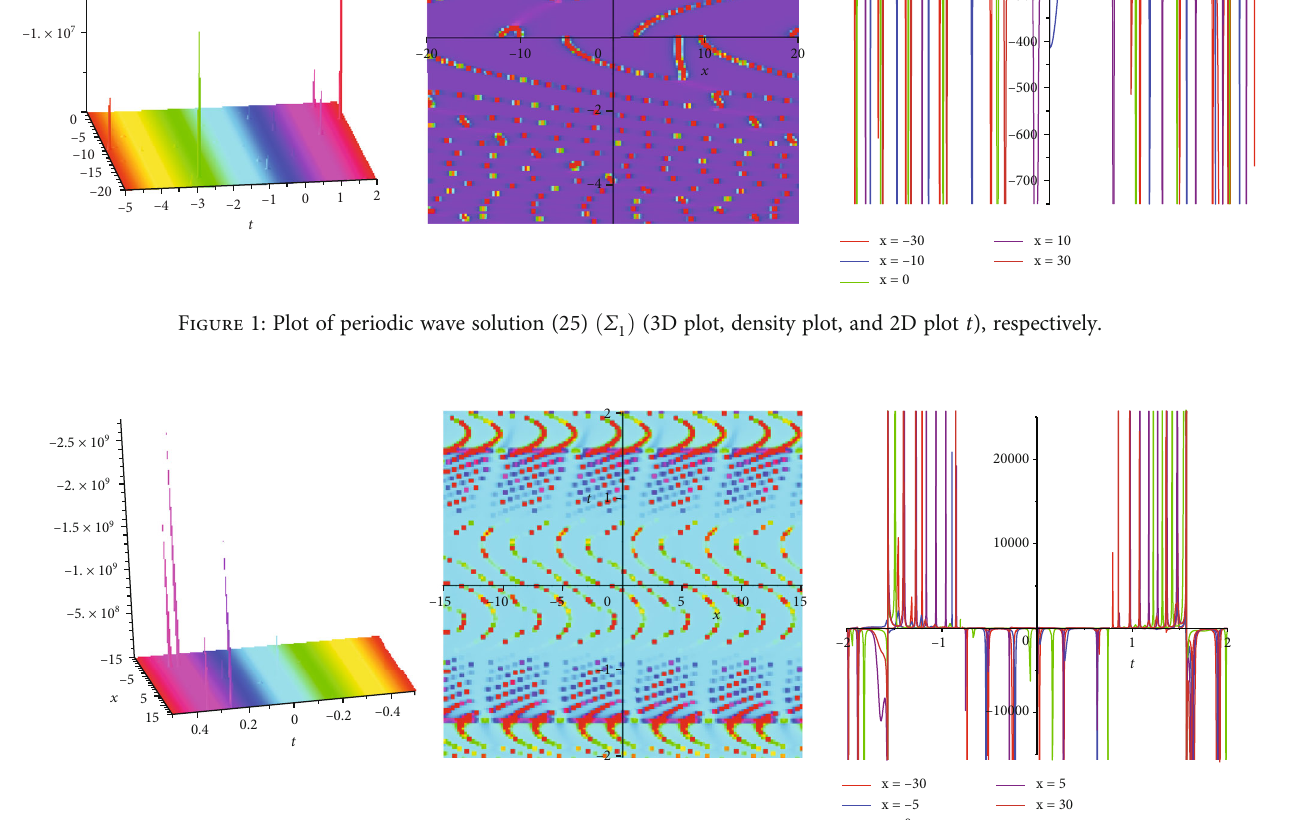
Figure 2: Plot of periodic wave solution (25) ð Σ